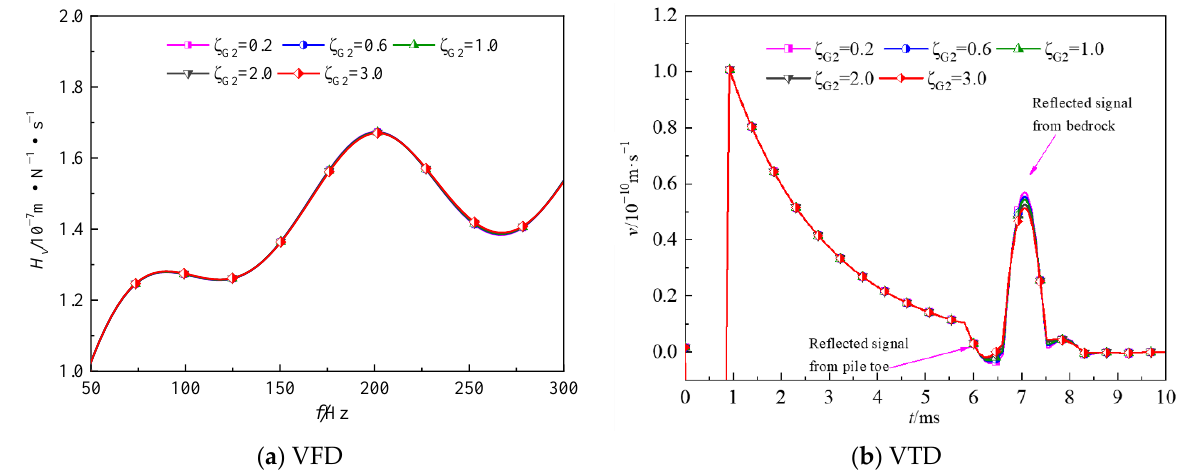
Figure 6. Influence of the vertical heterogeneity of pile end soils on the vertical vibration velocity.